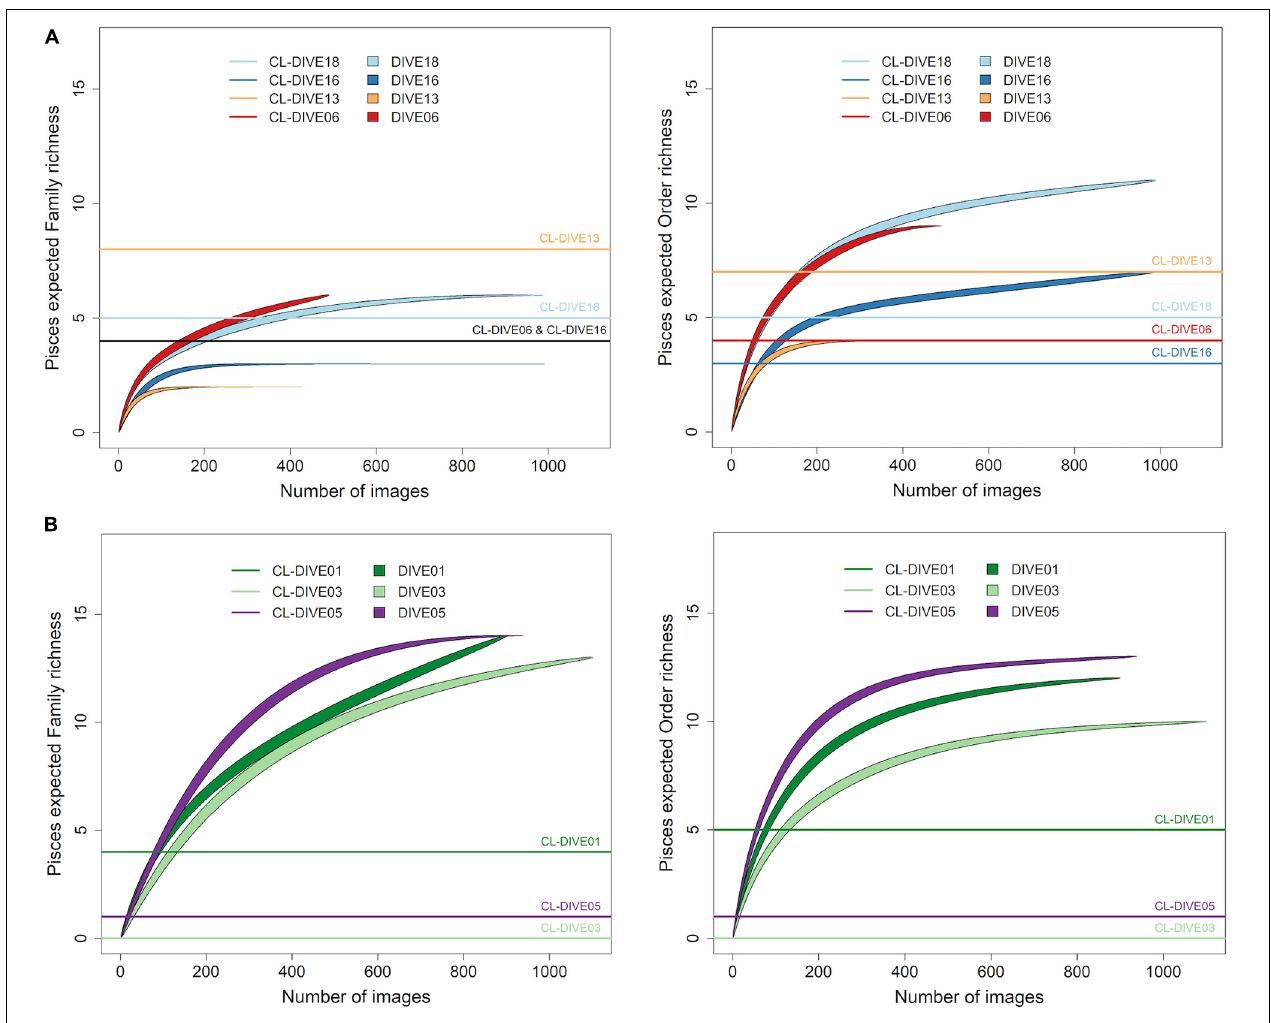
FIGURE 4 | Expected richness from rarefaction curves for Pisces at order and family ranks (exact method, n = 999 permutations), along (A) sedimented slope habitats (PNG) and (B) volcanic island slopes (Mayotte). Comparison between imagery (dive) and sampling along dive